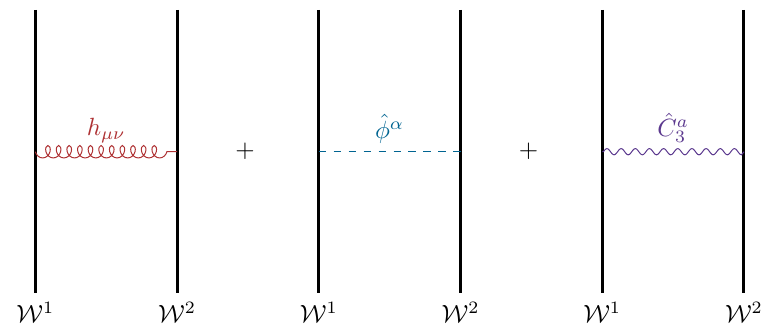
Figure 9 . The mutual interactions between two parallel membranes mediated by the graviton h µν , scalar fields ˆ φ α and gauge three-forms ˆ C a 3